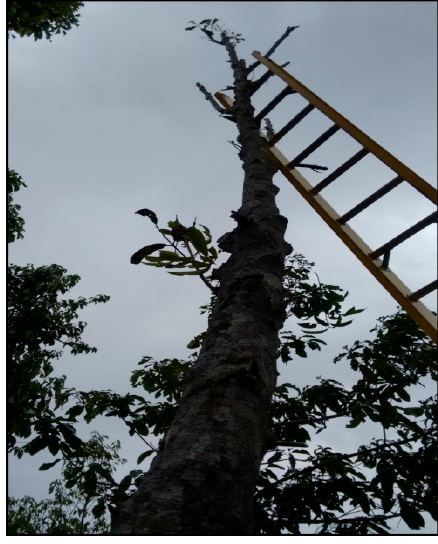
Figure A4 . 100% canopy pruning and canopy climbing ladder for removal of branches and leaves.